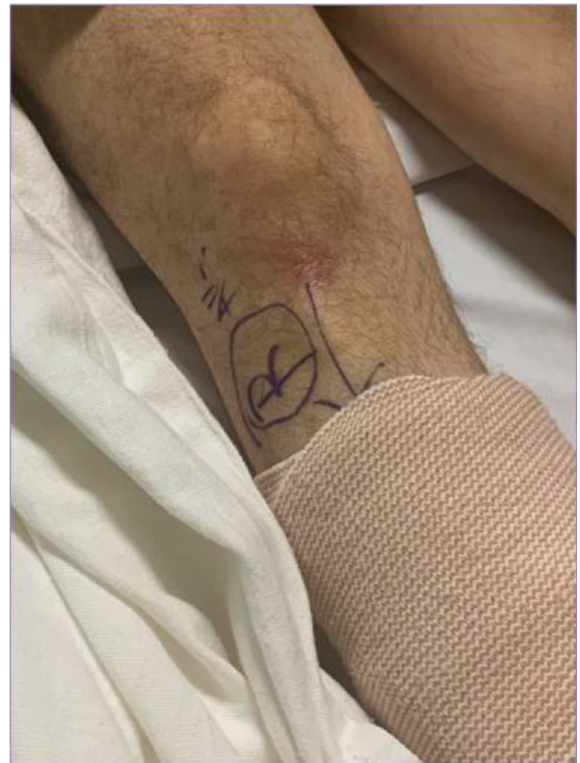
Figure 1: The surgical mark for Case 2 visible on the anterior portion of the patient’s operative leg, and the mark was easily visible during the performance of the adductor canal